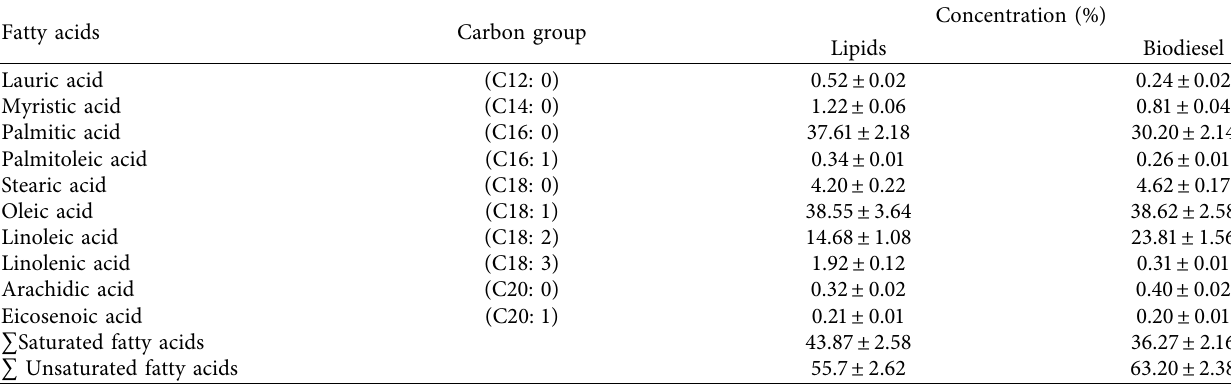
Table 4: Fatty acid compositions of scCO 2 extracted lipids from municipal sewage sludge (MSS) and sewage sludge